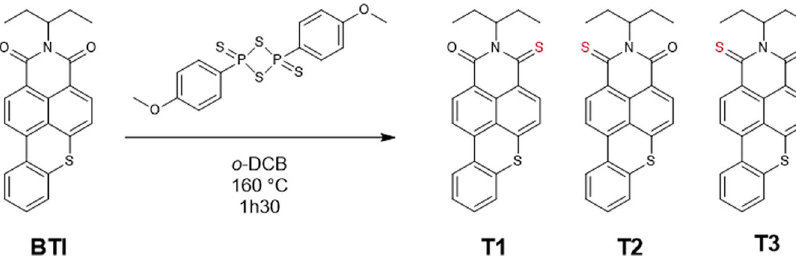
Fig. 1 Synthesized compounds. Thionation reaction of BTI afforded compounds T1 – T3